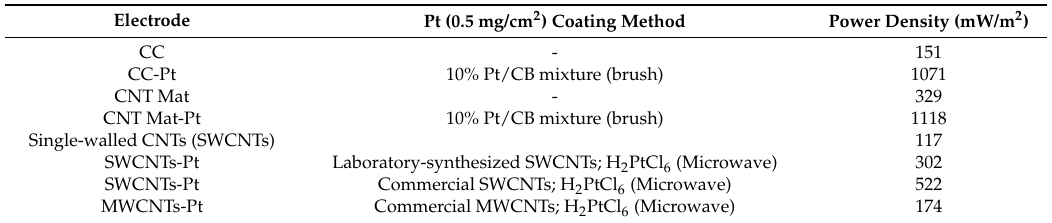
Table 4. Performance of the MFCs operated with different CNTs-based air-cathodes